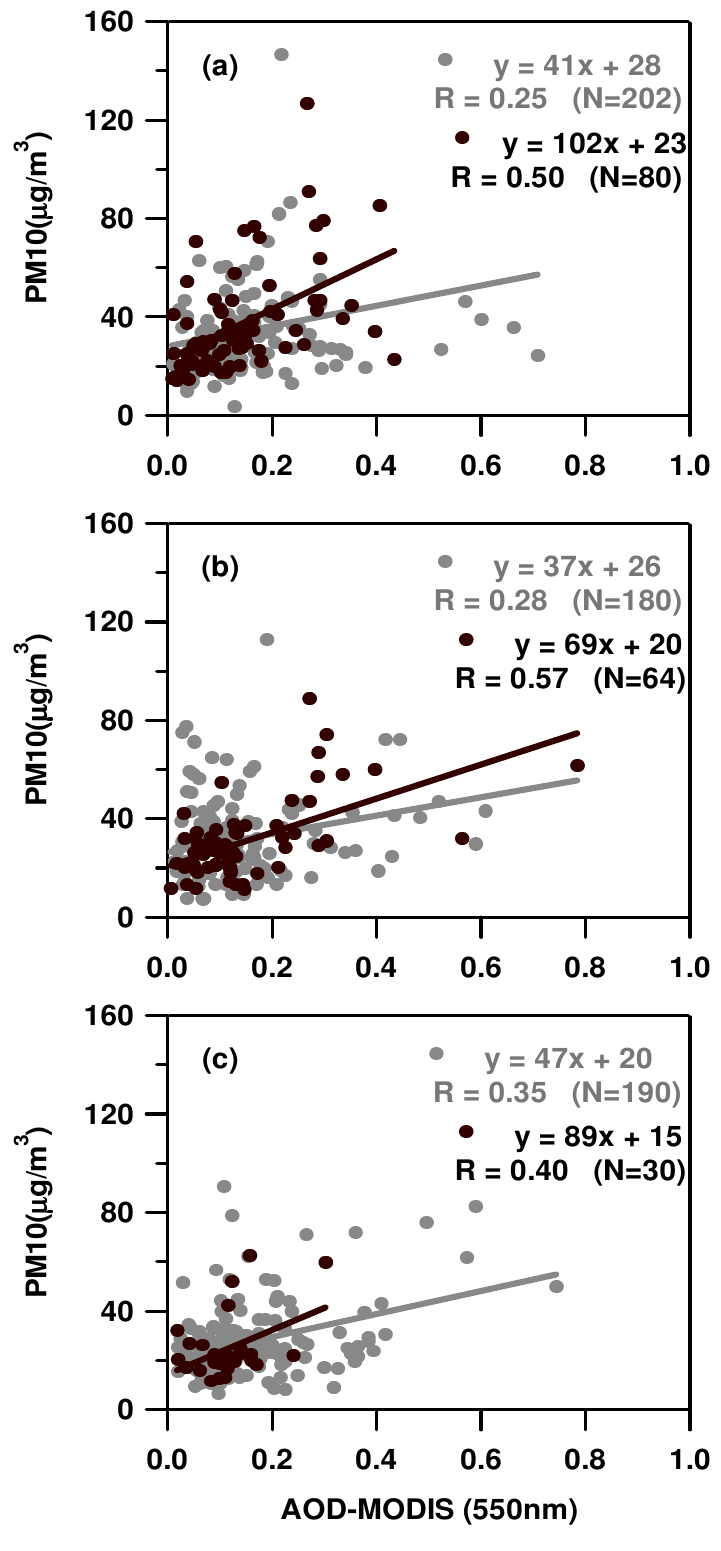
Figure 6. Scatterplot of PM10 mass concentrations versus co-located in space MODIS-AOTs at Guagnano for (a) 2006, (b) 2007, and (c) 2008. Slope, intercept and linear correlation coefficient ( R ) are also given in each plot, in addition to the total number of data points ( N ). Black dots represent data points referring to clear-sky MODIS measurements.